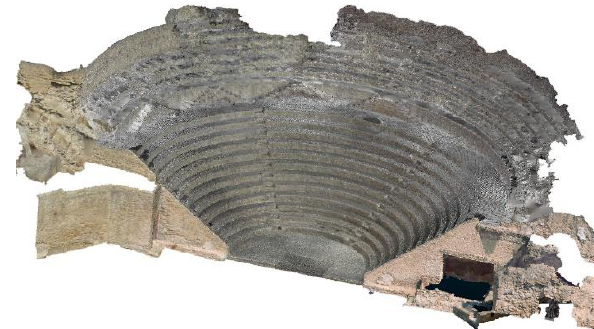
Figure 10: Textured 3D model of the Theatre.